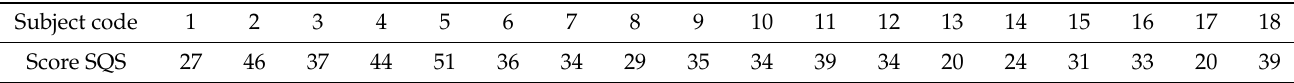
Table 1. Values for SQS